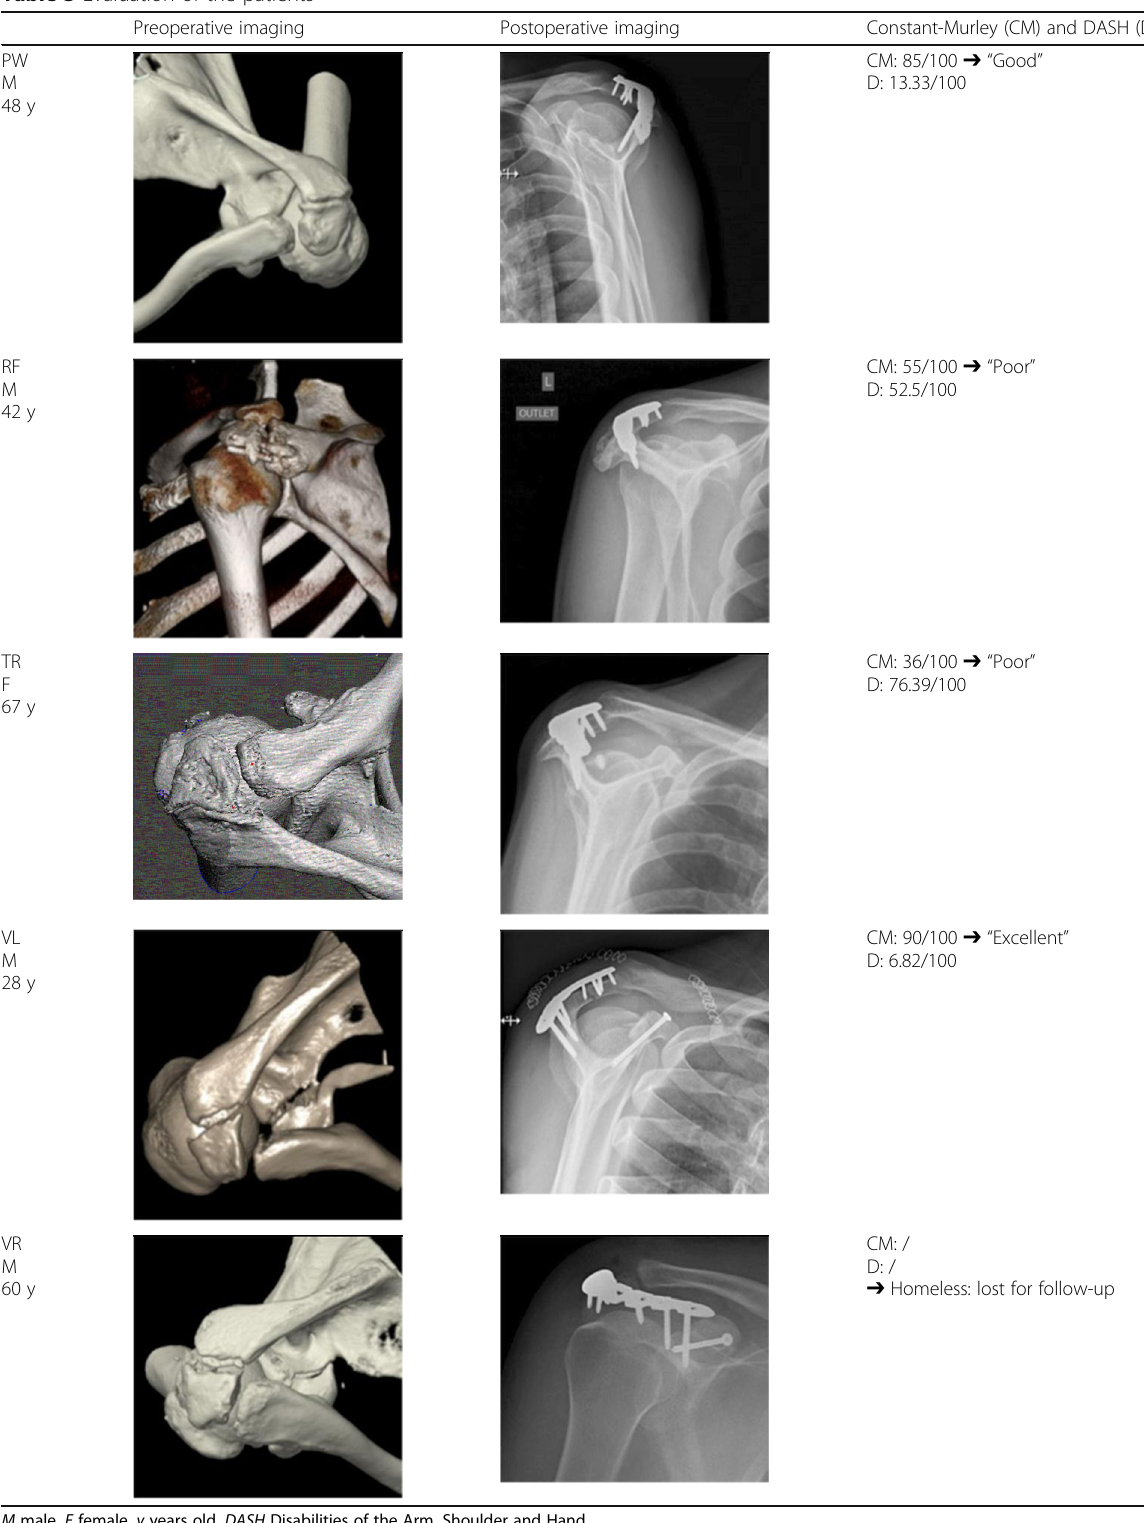
Table 3 Evaluation of the